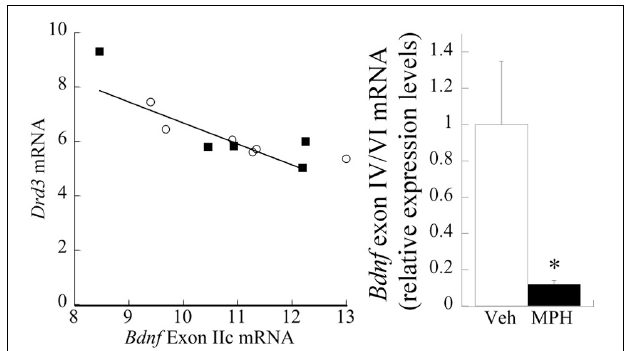
FIGURE 6 | Relationship between D3R, MPH, and BDNF exon splice variants. (left) Drd3 mRNA negatively correlates (Pearson’s r = − 0 . 73) with exon IIc expression. The filled squares represent the MPH subjects at P60, whereas the open circles are Veh. (right) Juvenile treatment with MPH significantly reduces exon IV/VI expression at 60 days of age relative to the Veh. n = 6/group, with Means ± SE presented. ∗ p < 0 .